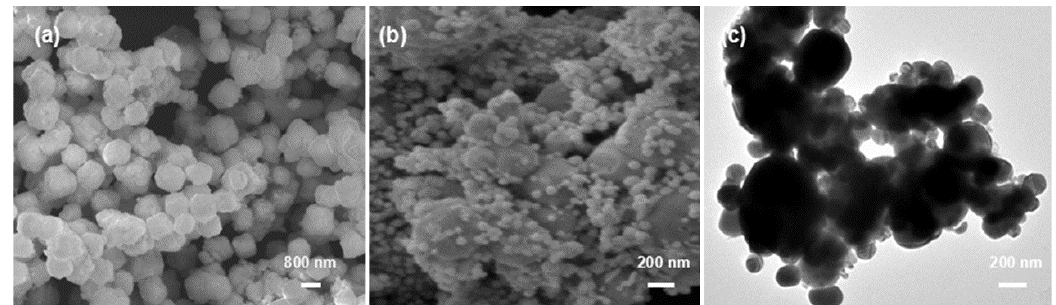
PO , (b) Ag PO /Ag and TEM image of (c) of Ag 3 4 3 4